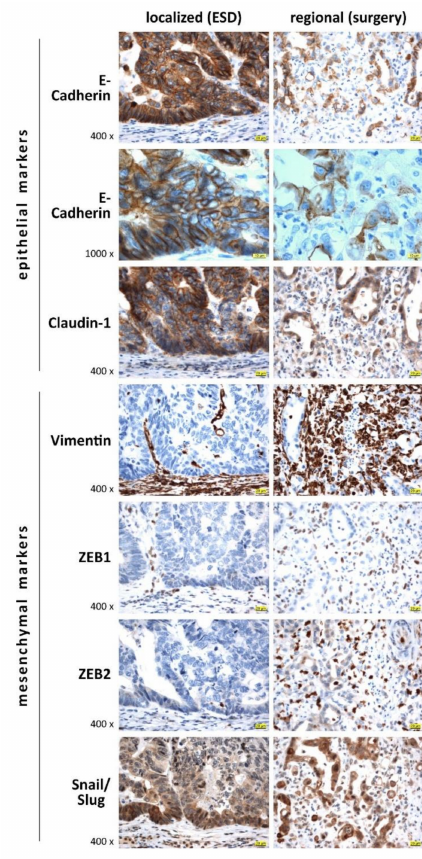
Figure 2. Representative IHC staining images of epithelial-to-mesenchymal transition (EMT) markers for selected localized (ESD-resected, (pT1, pN0) and regional (surgically resected (p > T1, pN1) cases of esophageal adenocarcinoma. For semiquantitative analysis of IHC staining, see Figure 3. Scale bar (yellow) indicates 20 or 10 µ m for 400 × and 1000 × magnification,